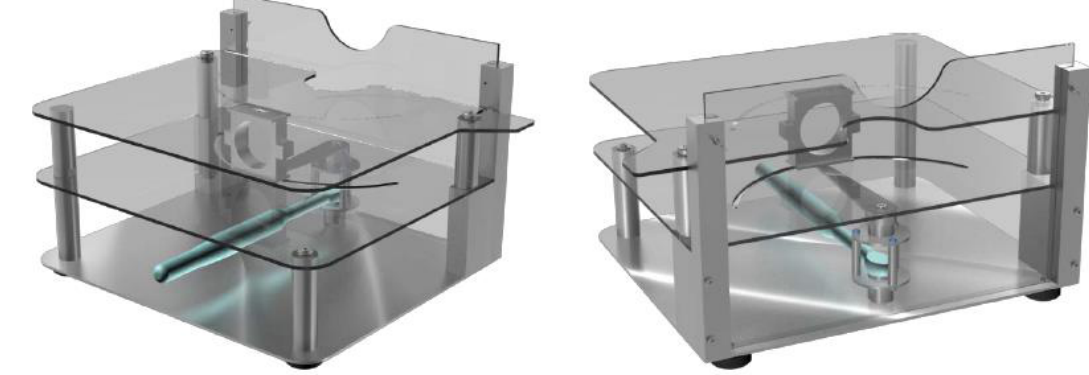
Figure 1. Electromechanical measurement device.